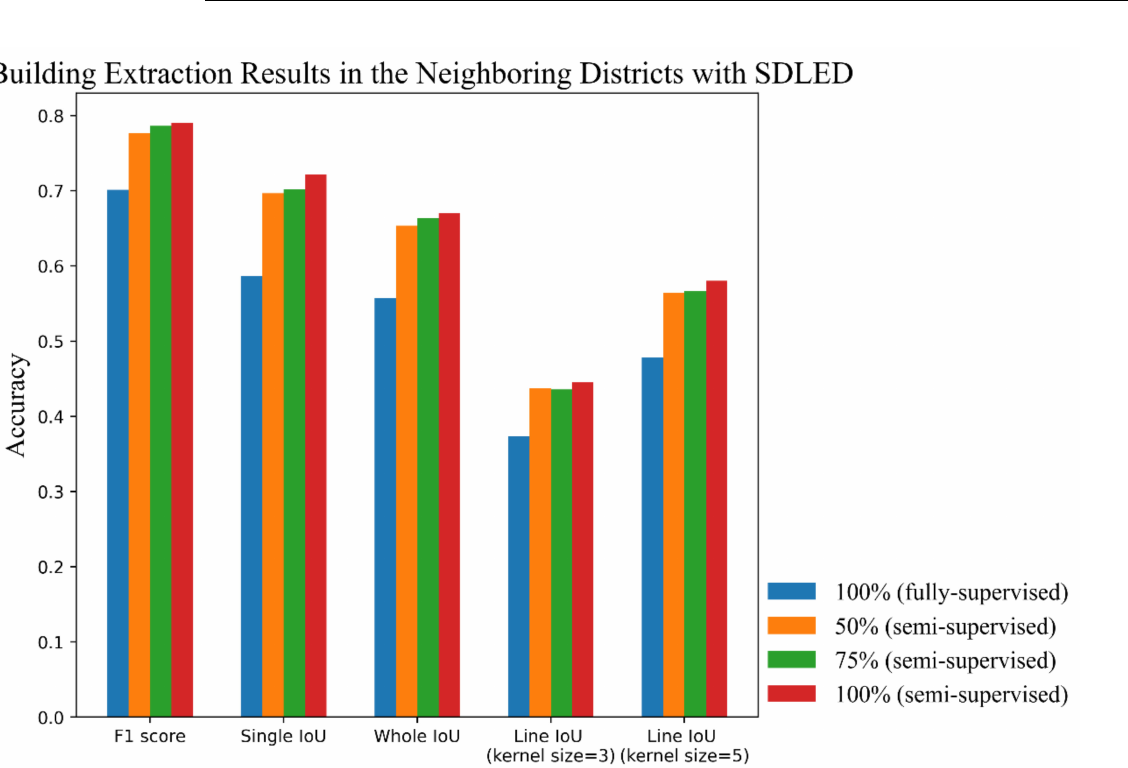
Figure 8. Precision evaluation results for generalization ability analysis in